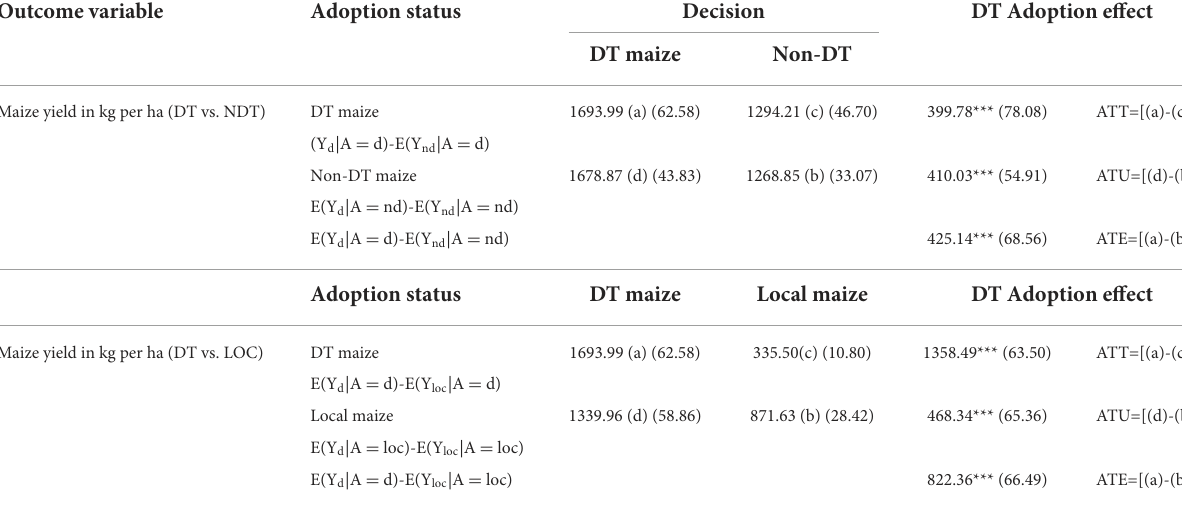
TABLE 4 Average effect of DT maize adoption on maize yield, multinomial ESR.